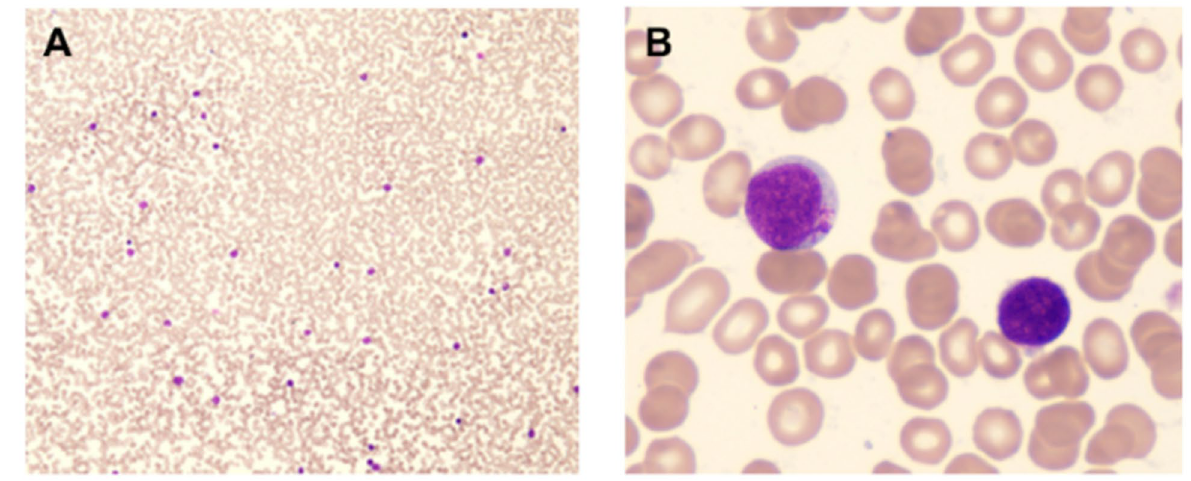
Fig. 3 Karyotype analysis of PB sample: 45,XX, t(3;3)(q21;q26.2), add[5](q22), del[7](q31q34), add(11)(p15), -12[20]. Abnormalities in chromosome 3, 5, 7, 11 and 12 (arrows) were